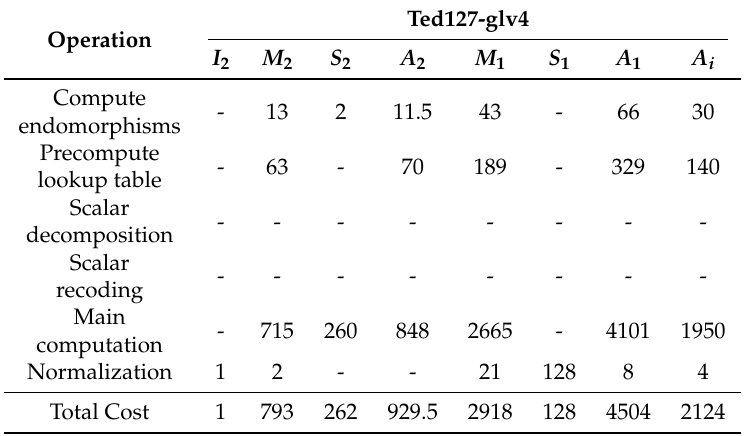
Table 1. The operation counts of curve Ted127 - glv4 using field arithmetic over F p 2 and operation counts for conversion into field arithmetic over F p .